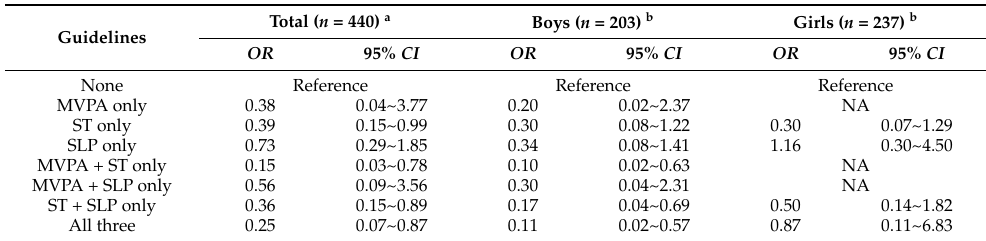
Table 3. Associations between meeting the 24-Hour Movement Guidelines and overweight and obesity in Chinese children and adolescents.